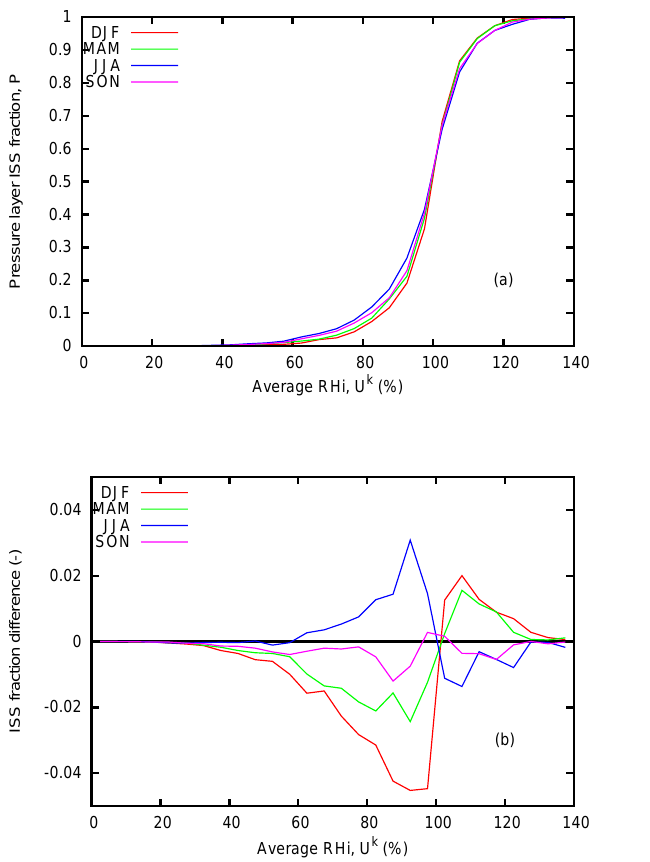
Fig. 11. The relationship between average RHi and the ISS fraction within 50-hPa pressure layers, comparing Gibraltar and the Falkland Islands to the Bristish Isles mean is shown in panel (a) . The differences between them and the British Isles average curve are shown in panel (b) . These data are derived from six high resolution radiosonde launch stations within the British Isles and one from both Gibraltar and the Falkland Islands (January 2002–December 2006).